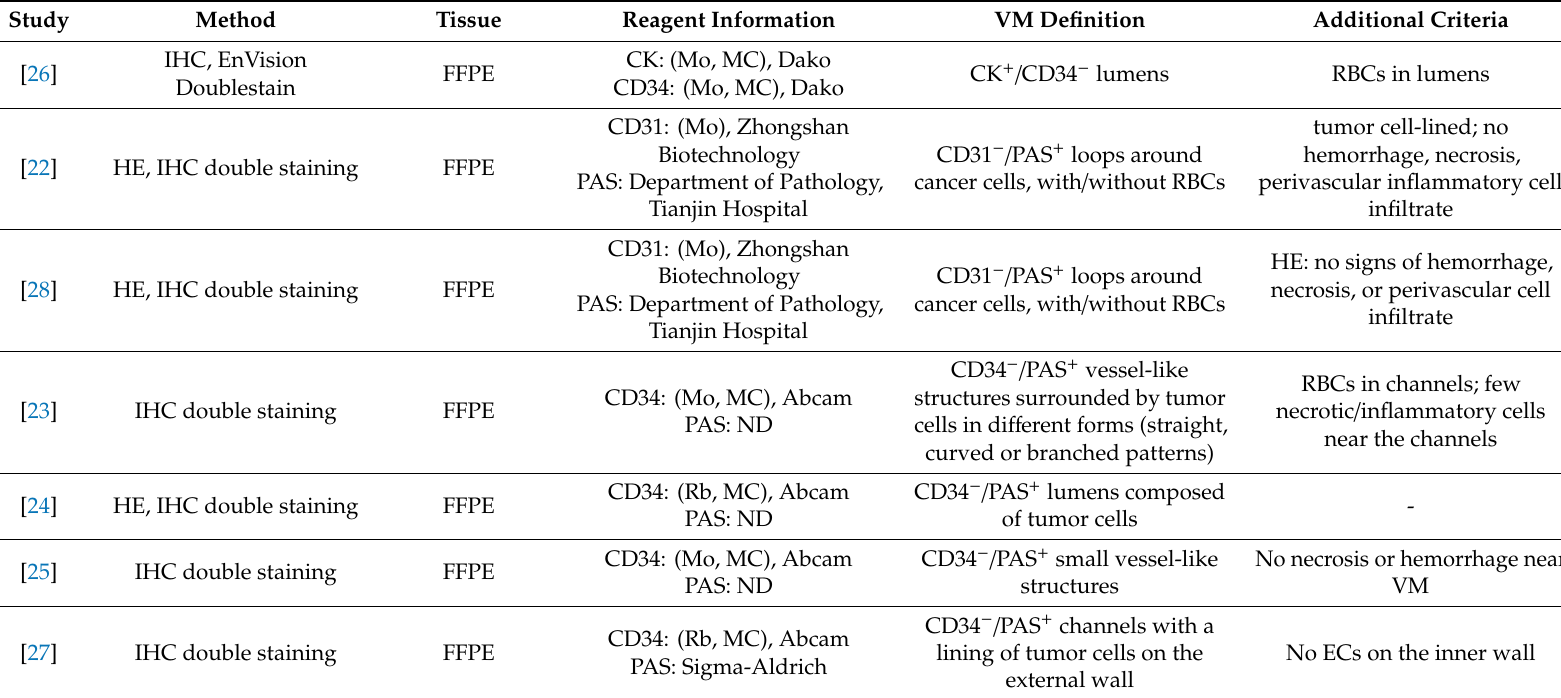
Table 3. Summary of vasculogenic mimicry identification